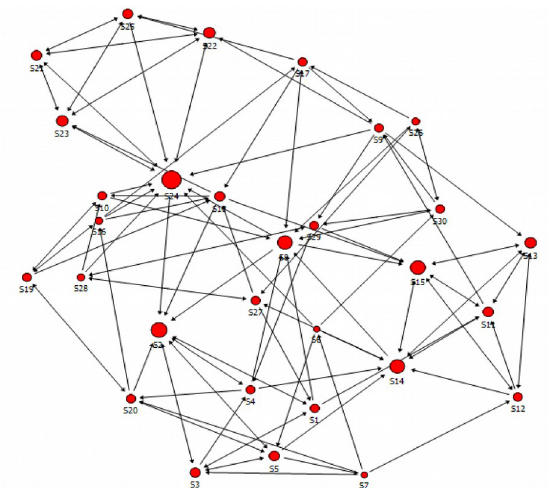
Figure 2. Relationships Maps After Class